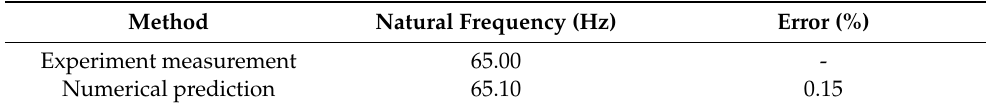
Table 2. Comparison of first natural frequencies of the proposed bearing under dry condition, being on a ground (without a plastic box) between experimental and numerical results.